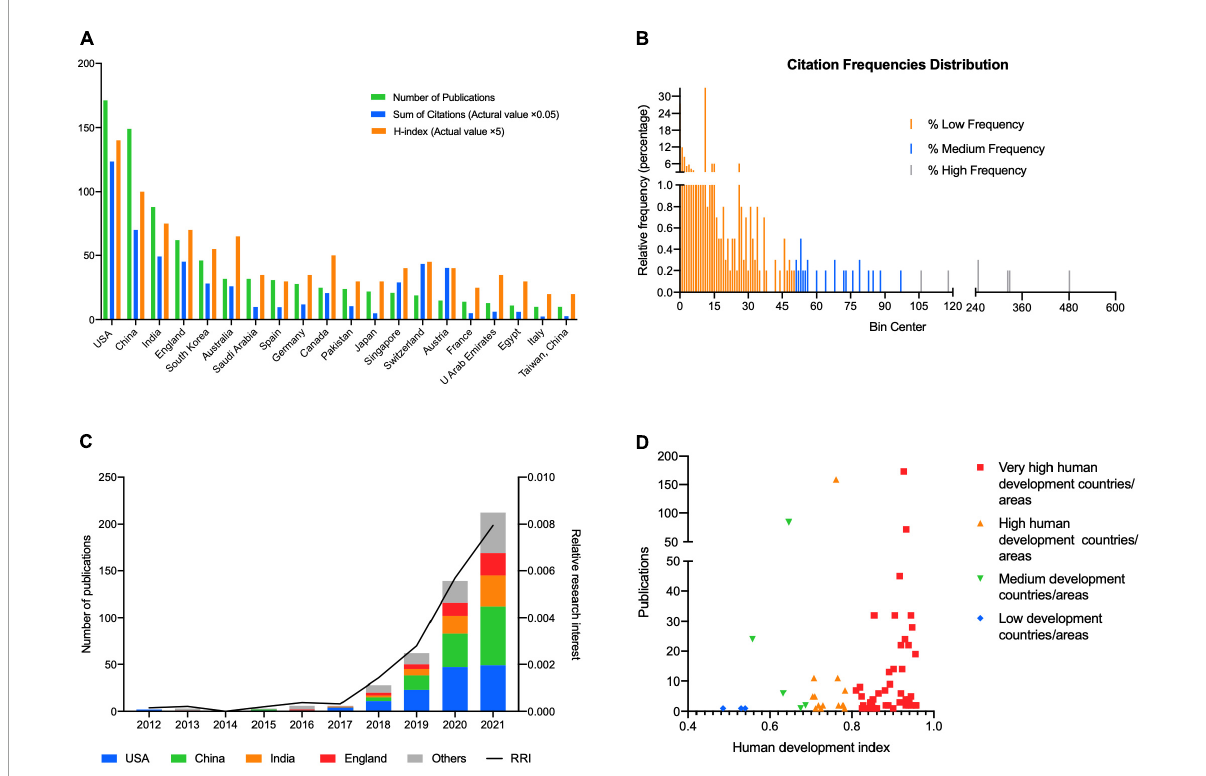
FIGURE1 (A) Top 20 countries/regions in the publications of artificial intelligence in retina. The green bar shows the number of publications, the blue bar shows the sum of citations in total (actual value multiply by 0.05), and the orange bar shows the H-index (actual value multiply by 5). (B) The relative frequency (percentage) distribution of publications in various citation number. The publications were divided into three groups according to the total citation frequency, including high citation frequency (more than 100 citations) group, medium frequency (more than 50 citations and < 100 citations) group, and low frequency ( < 50 citations) group. (C) The proportion of publications of USA, China, India, England, and other countries/regions and relative research interest (RRI) in each year on the field of artificial intelligence in retina. (D) The number